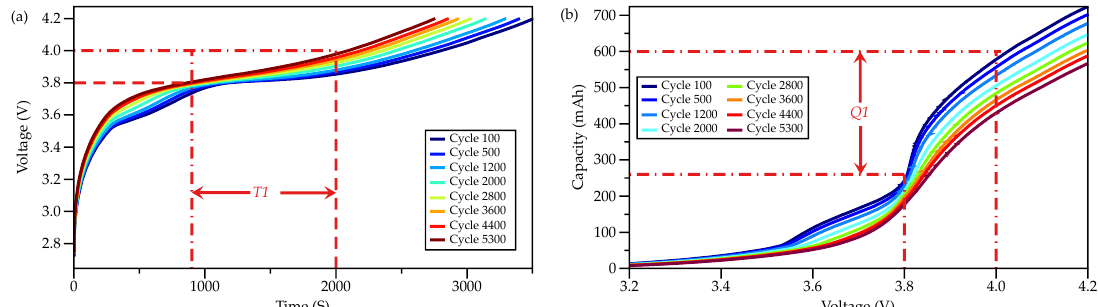
Figure 4. ( a ) Terminal voltage curves of cell 1; ( b ) Charging capacity curves of cell 1.